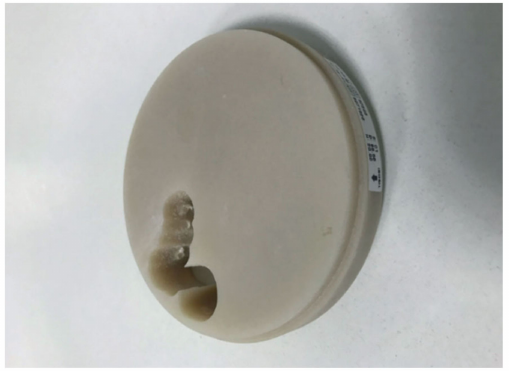
Figure 4. PMMA disk, reprinted with permission from ref. [44] (Copyright 2020 In˙zynier i Fizyk Medyczny).